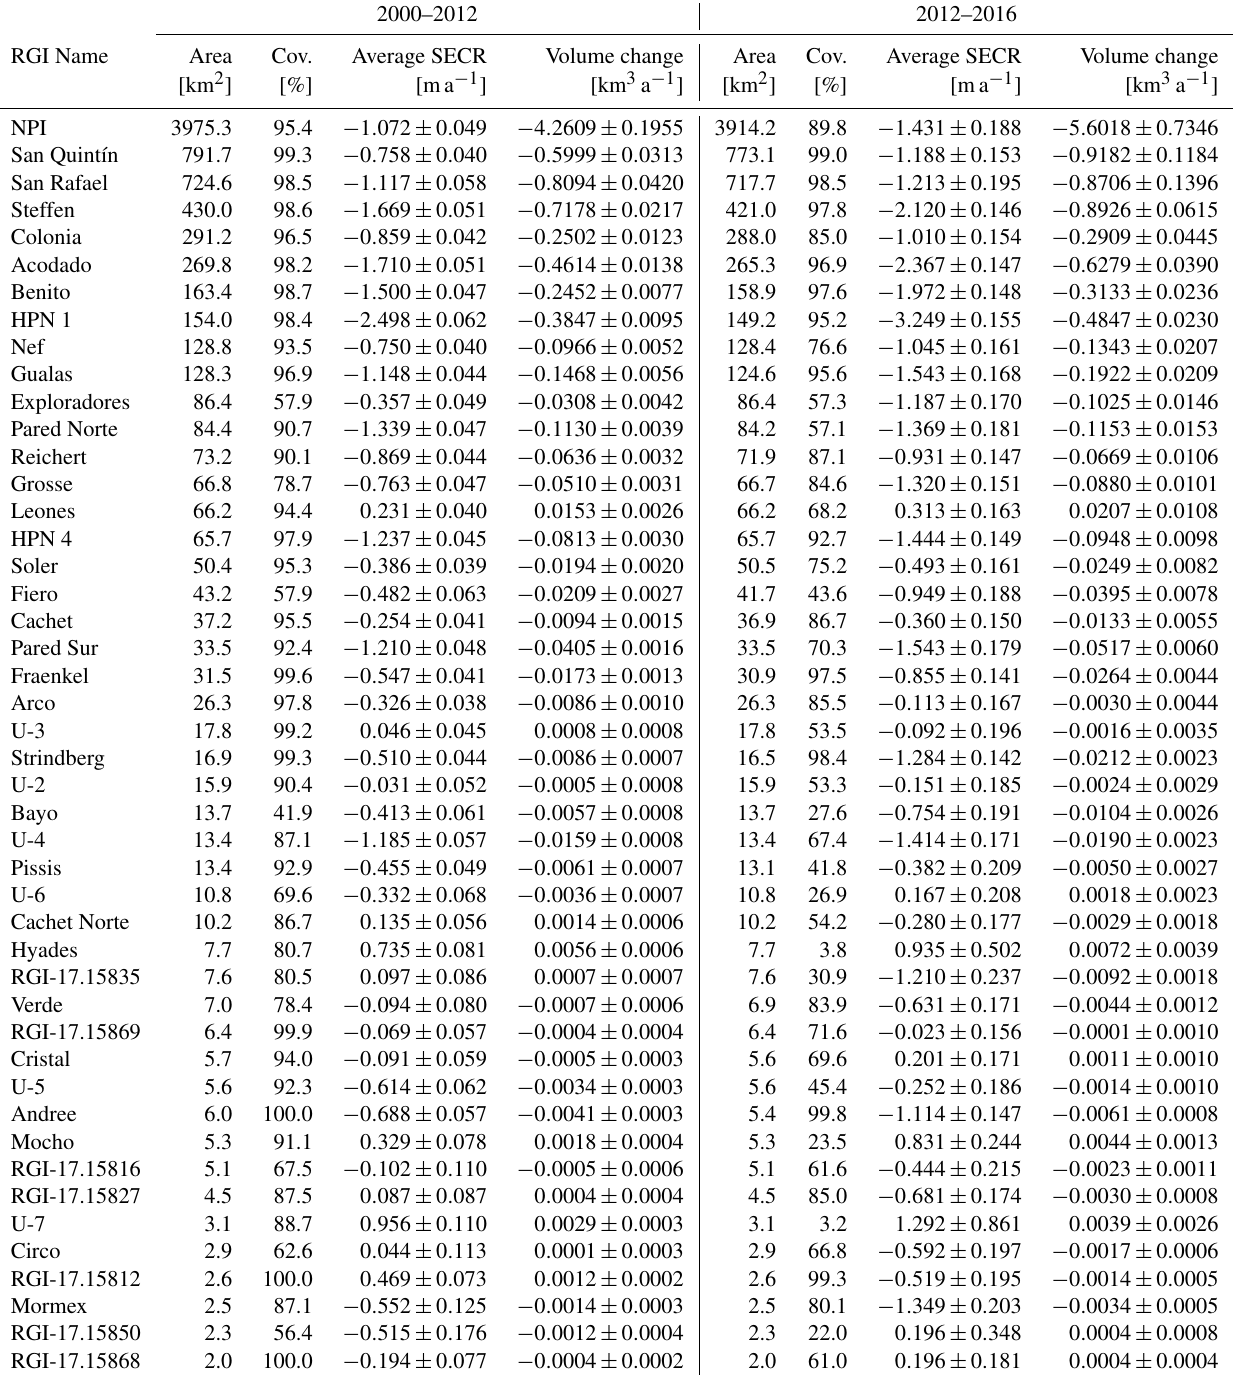
Table 2. Average surface elevation change rate (SECR) and volume change rate (VCR) for NPI and its glaciers larger than 2 km 2 for the two epochs. The reported area refers to the beginning of the epoch; the coverage of the SECR map is also reported. Subaqueous ice changes are not